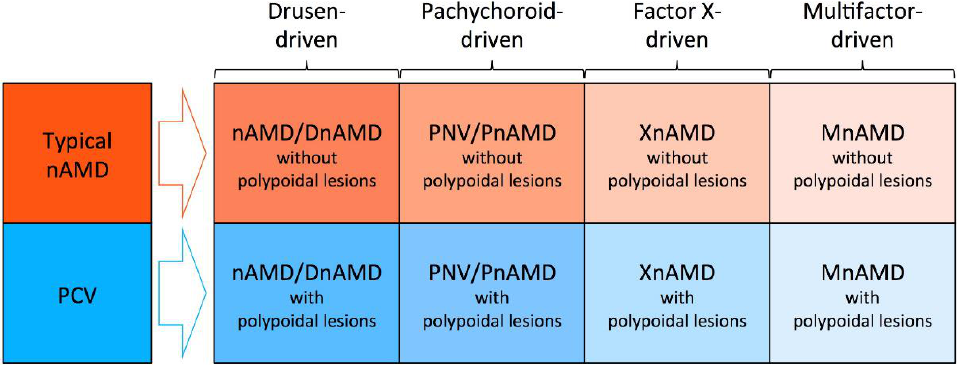
Figure 5. Possible future framework for neovascular age-related macular degeneration (nAMD). Typical nAMD might be divided into drusen-driven nAMD without polypoidal lesions, pachychoroid neovasculopathy (PNV) without polypoidal lesions, factor X-driven AMD without polypoidal lesions, and multifactor-driven mAMD without polypoidal